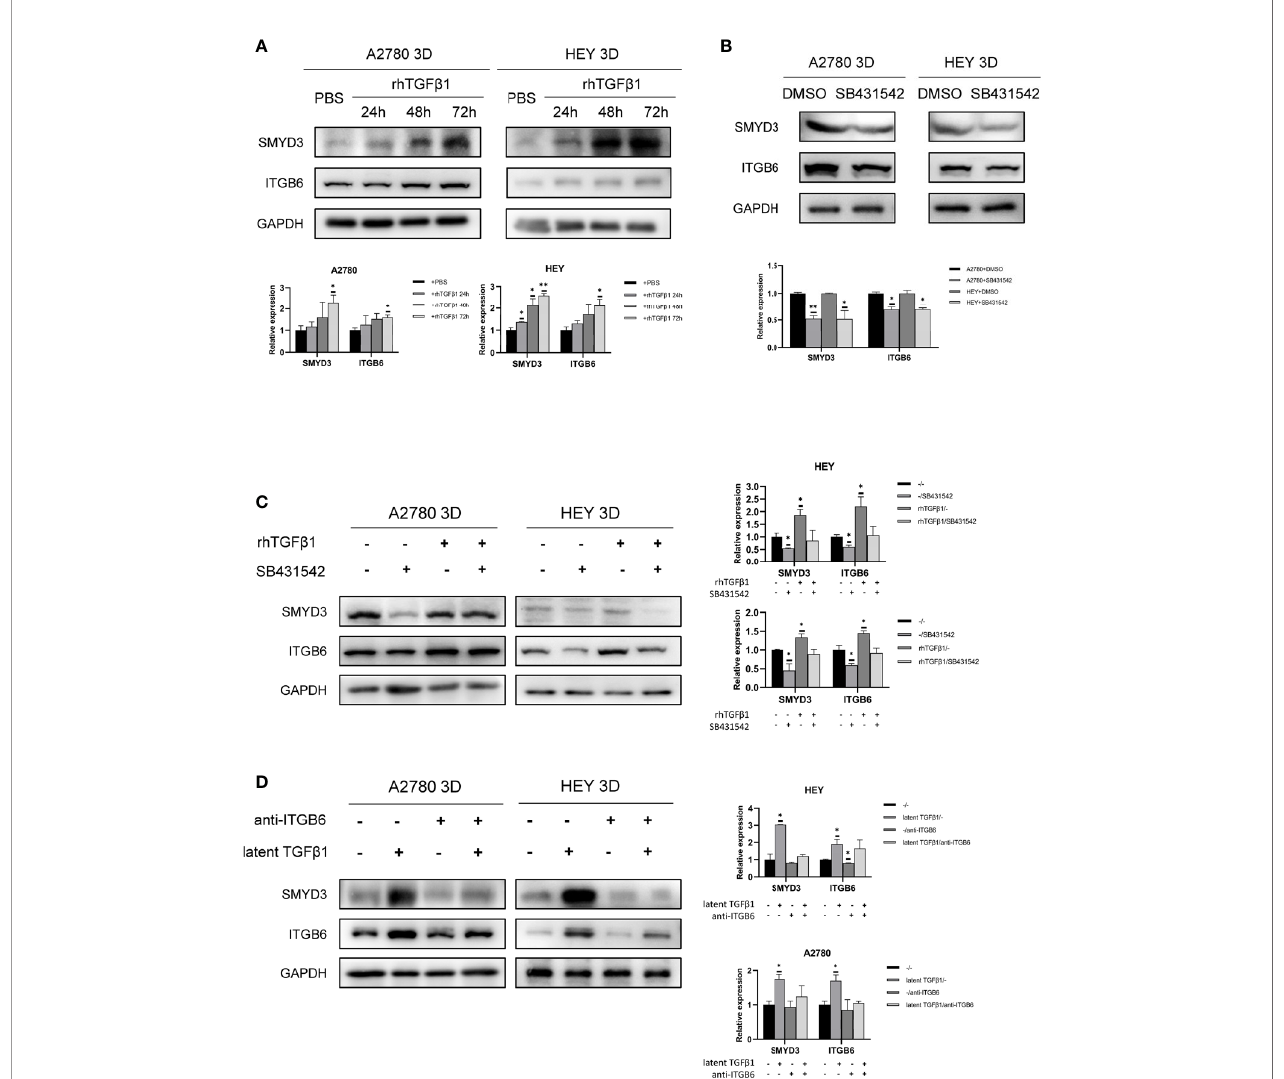
FIGURE 6 | TGF b 1 can promote the expression of SMYD3 and ITGB6 via feedback. (A) Changes in the expression of SMYD3 and ITGB6 in 3D-cultured HEY and A2780 cells after treatment with 10 ng/ml recombinant human TGF b 1 protein for 24, 48 and 72 h. (B) Changes in the expression of SMYD3 and ITGB6 in 3D- cultured HEY and A2780 cells after treatment with 10 m M SB431542 for 24, 48 and 72 h. (C) Changes in the expression of SMYD3 and ITGB6 in 3D-cultured HEY and A2780 cells after treatment with or without rhTGF b 1 and SB431542. RhTGF b 1 protein (10 ng/ml) was added to the culture medium and incubated for 72 h. Then, 10 m M/ml SB431542 was added to the medium and incubated for 6 h (equal doses of PBS and DMSO were used as the negative controls for rhTGF b 1 and SB431542, respectively). (D) Changes in the protein expression of SMYD3 and ITGB6 in 3D-cultured HEY and A2780 cells after treatment with or without latent TGF b 1 and anti-ITGB6. In the histogram of the western blot quanti fi cation, “ * ” refers to p < 0.05 and “ ** ” refers to p <